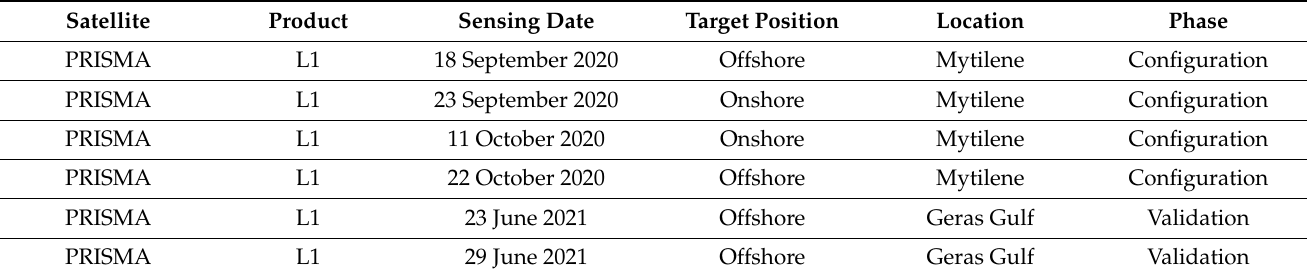
Table 3. Summary of collected satellite data.